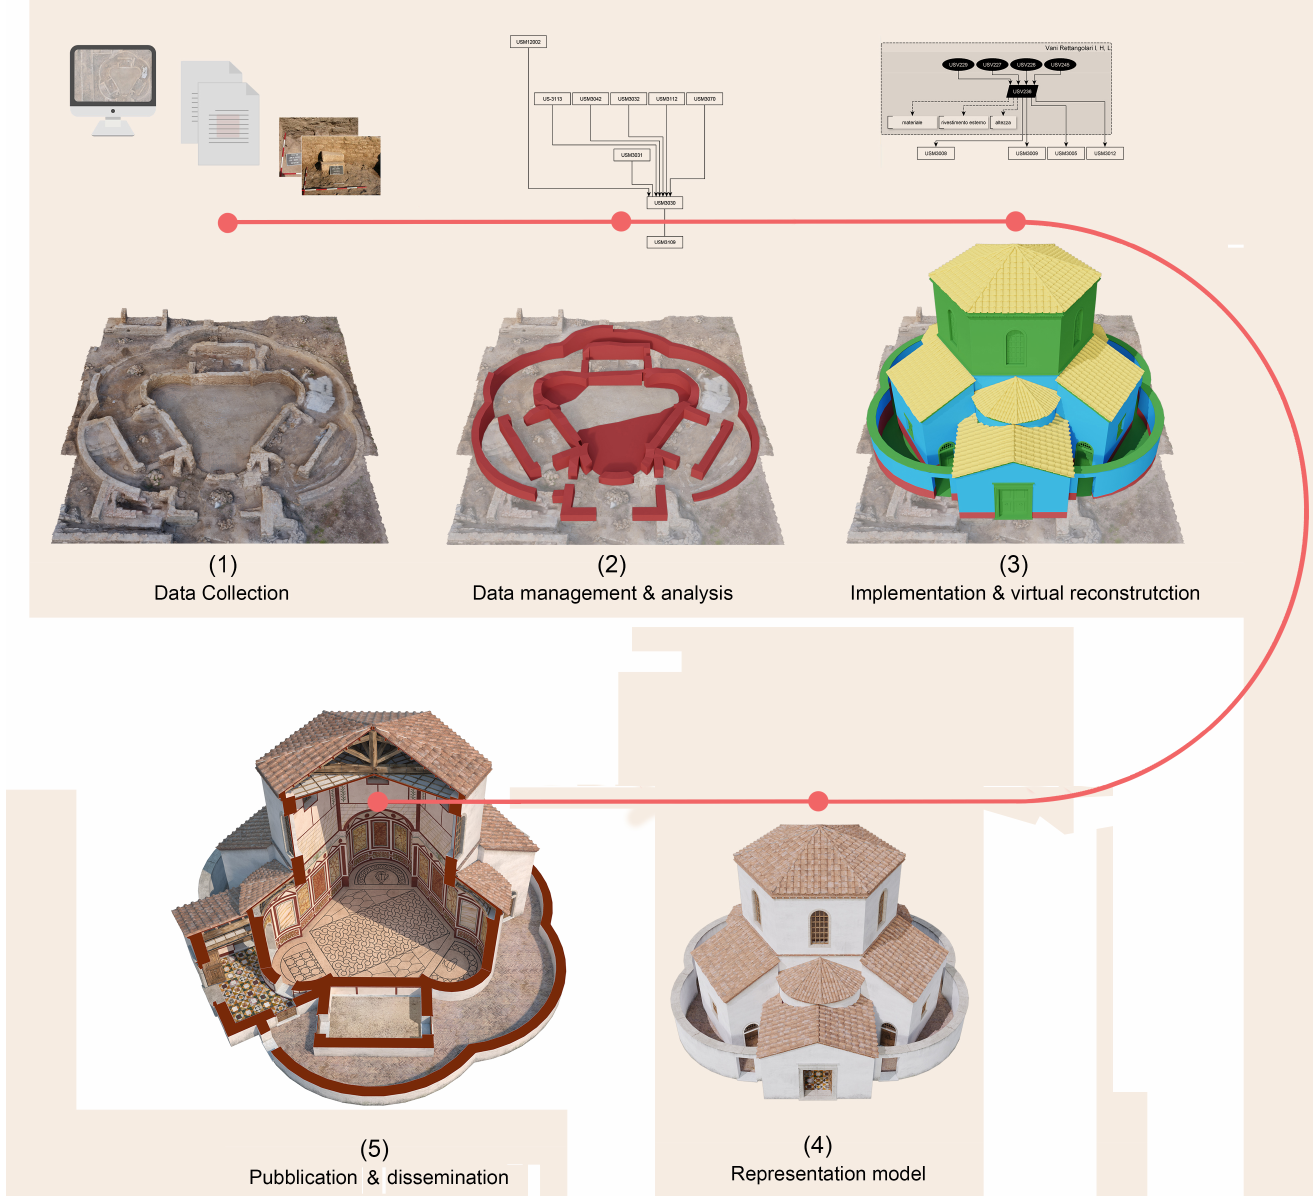
Figure 2. An overview of the reconstructive process: (1) Data collection: digital replica of an archaeological site and related sources; (2) Data management and analysis: proxy model of the extant structure semantically enriched with stratigraphic information from the Matrix; (3) Implementation and virtual reconstruction: proxy model of the reconstructive hypotheses is drawn and connected with the EM. See colour chart in Table 3; (4) Representation model: reconstructive model provided with textures and materials; (5) Publication and dissemination: rendering of the model according to the chosen aesthetic style and the publication